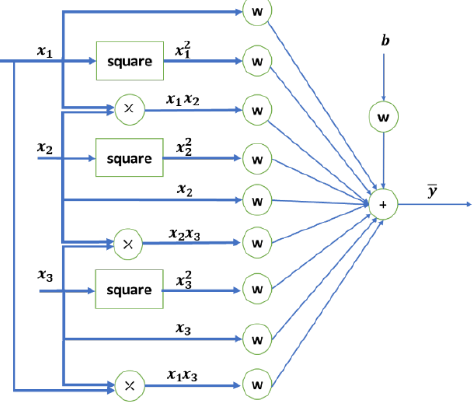
Figure 2. Topology of GMDHNN.